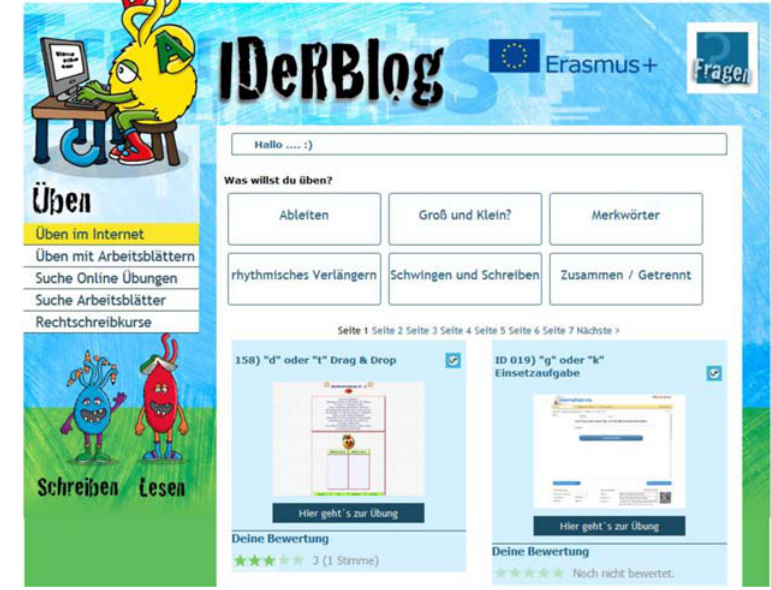
Figure 4. Overview of the exercises for children categorized by